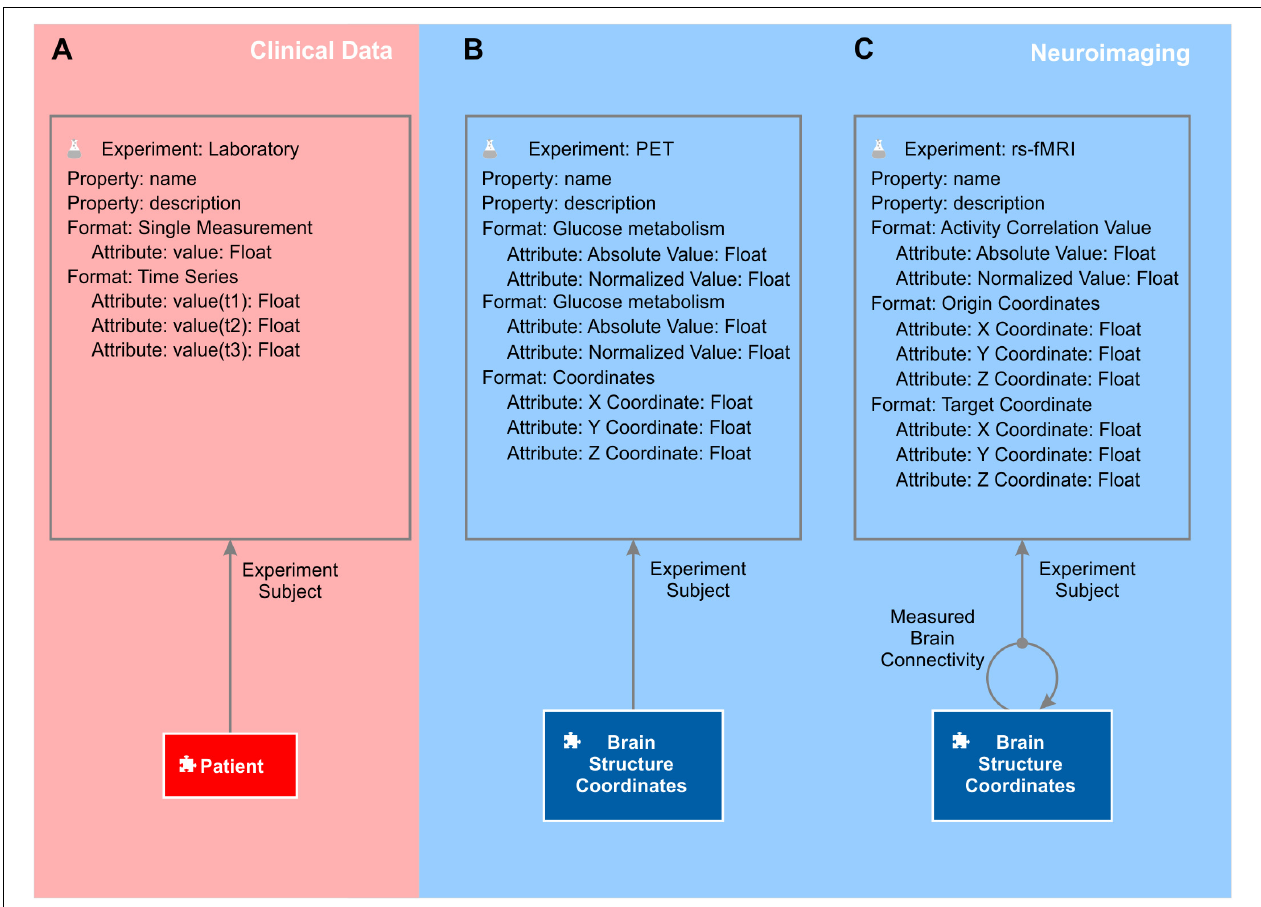
FIGURE 4 | Laboratory and neuroimaging experiments. Every experiment is defined by its name, method, subject, and format. Every format can contain different attributes to accommodate the data. (A) In the clinical subdomain, the experiment method “laboratory” contains all measurements of the patient such as blood values. The patient is the subject of each experiment method laboratory. The main differences between laboratory experiments and neuroimaging experiments is that the latter do not have the patient as the experiment subject. (B) Neuroimaging experiments that measure, for example, glucose metabolism at a particular location in the brain, such as the experiment method “PET,” have the element “brain structure coordinates” as the subject. (C) Experiments that measure connectivity between “brain structure coordinates” (e.g., by experiment method “rs-fMRI”) have the semantic relation “measured brain connectivity” as the